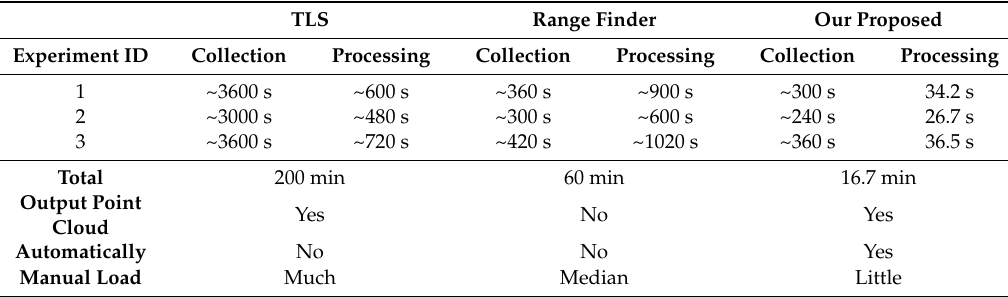
Table 7. E ffi ciency evaluation of the proposed